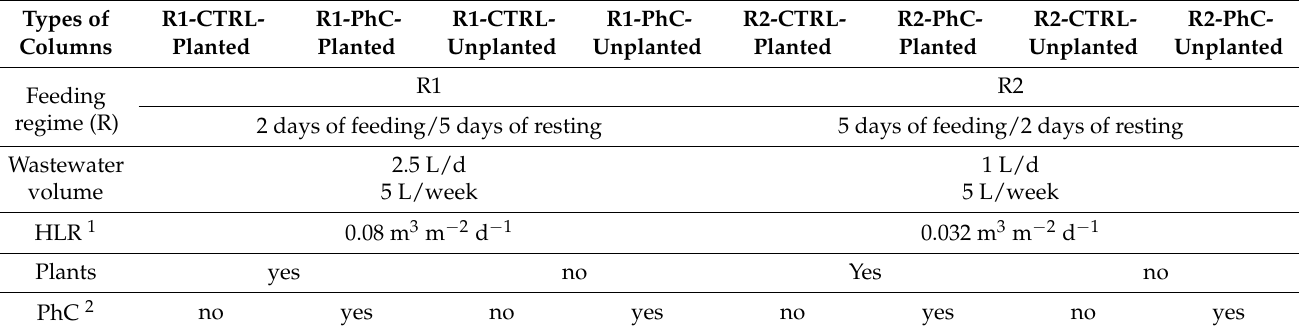
Table 2. Types of columns used in the